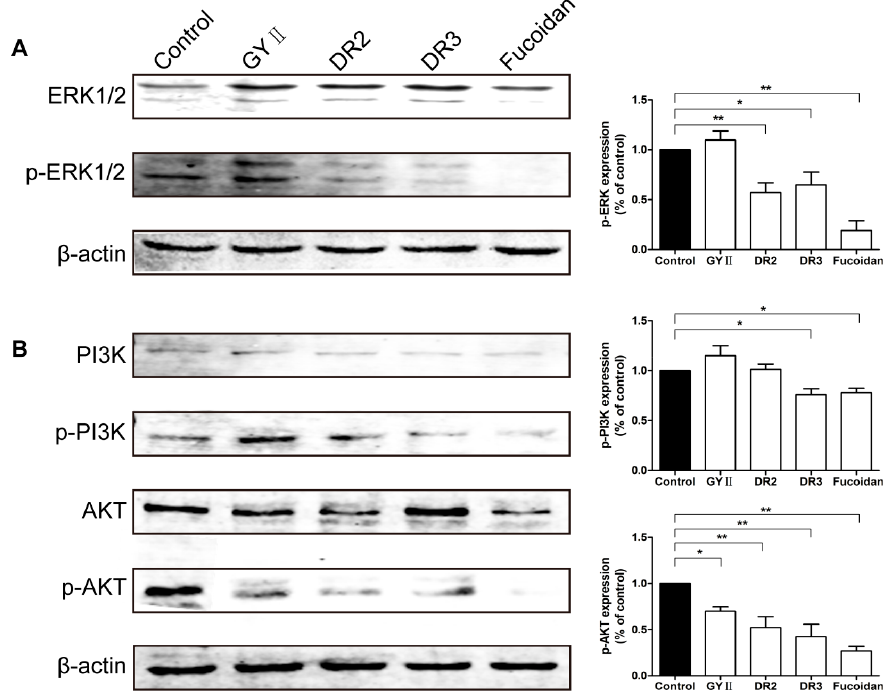
Figure 8. GYII and its decomposed recipes regulated the extracellular signal-regulated kinase (ERK) and phosphatidylinositol-3-kinase/ serine-threonine kinase (PI3K/AKT) pathways in 4T1 cells. Cells were treated with the test compounds and the levels of ( A ) p-ERK; ( B ) p-PI3K and p-AKT were detected by Western blotting. Data are presented as the mean ± SD and normalized to β -actin (* p < 0.05, ** p < 0.01).